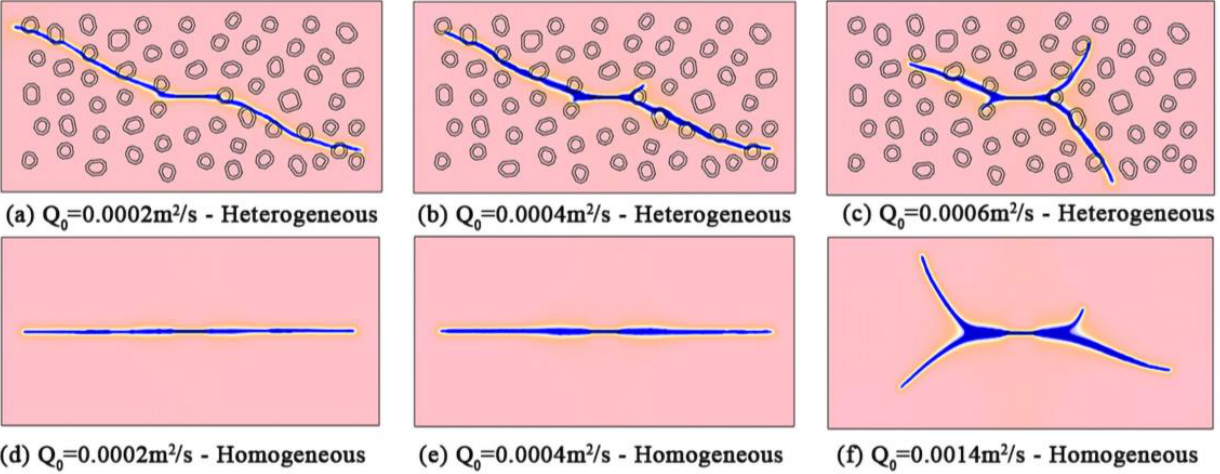
Figure 5. Fracture morphologies for different injection rates in homogeneous and heterogeneous reservoirs, respectively.